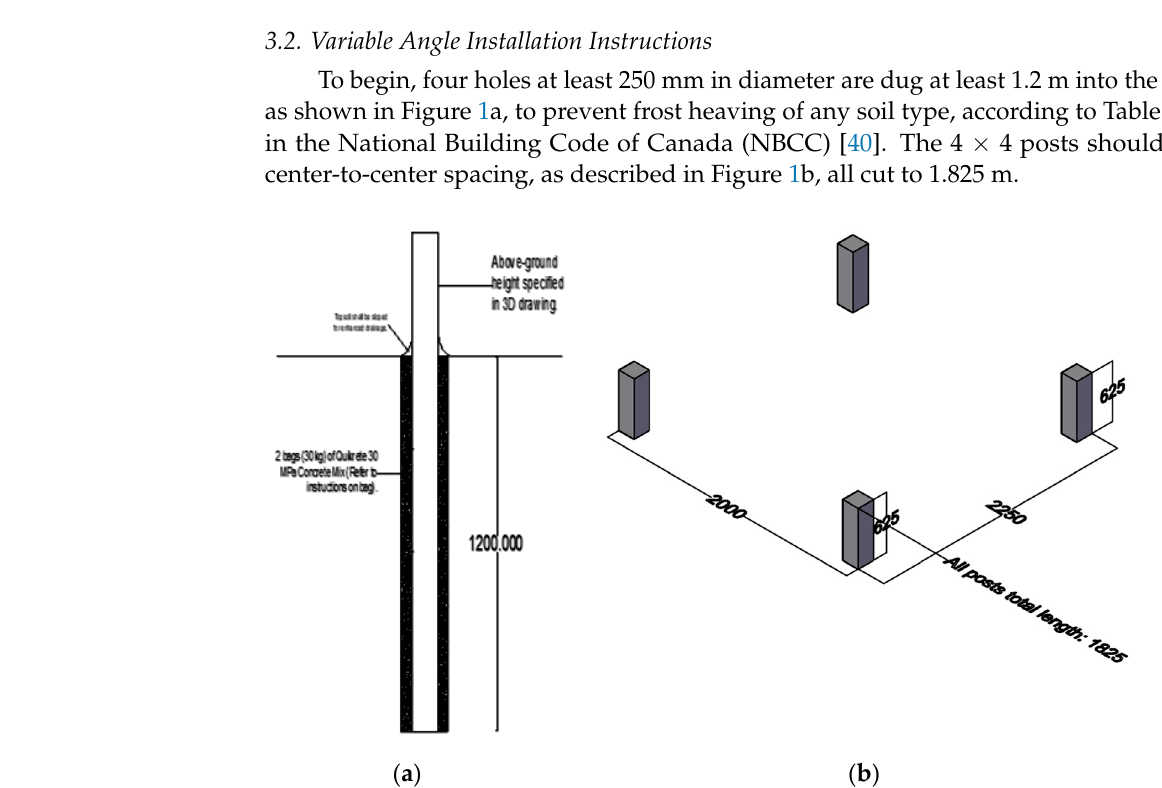
Figure 1. ( a ) Foundational installment of vertical posts, and ( b ) center-to-center spacing of vertical posts. vertical